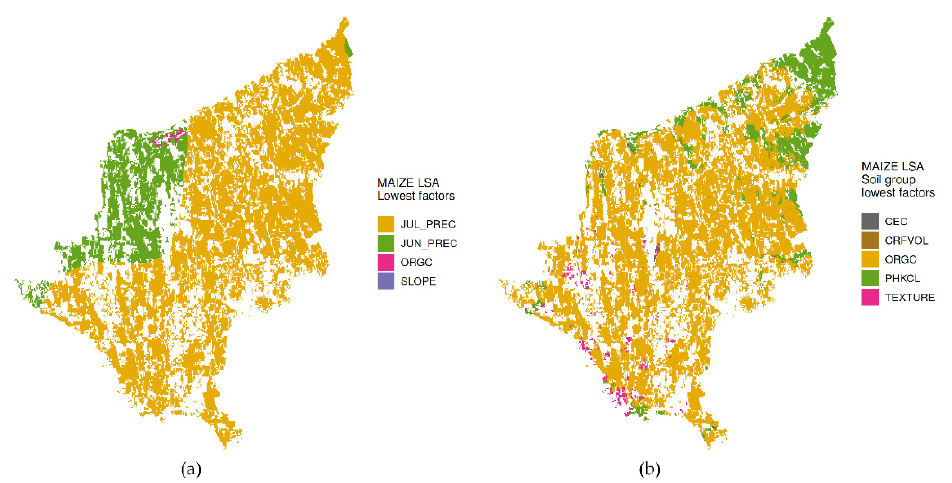
Figure 8. LS classes for maize in Somogy.